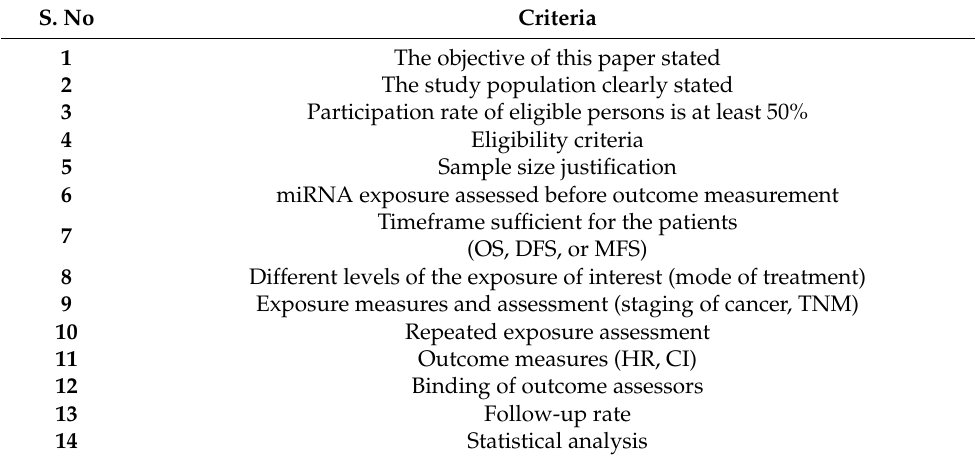
Table 2. The Meta-Analysis of Observational Studies in Epidemiology (MOOSE)